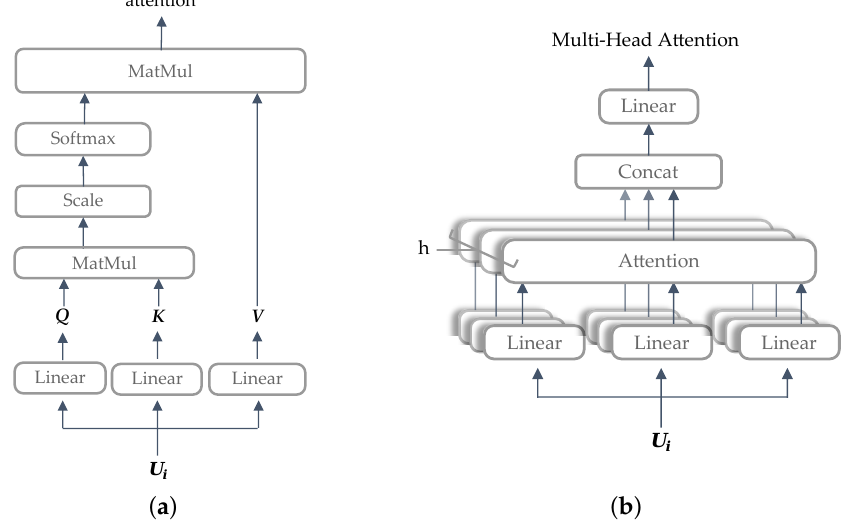
Figure 7. Attention mechanism in this paper: ( a ) weighted fusion of features calculated by scaled dot-product self-attention; ( b ) weighted fusion of features in different representation subspaces calculated by Multi-Head